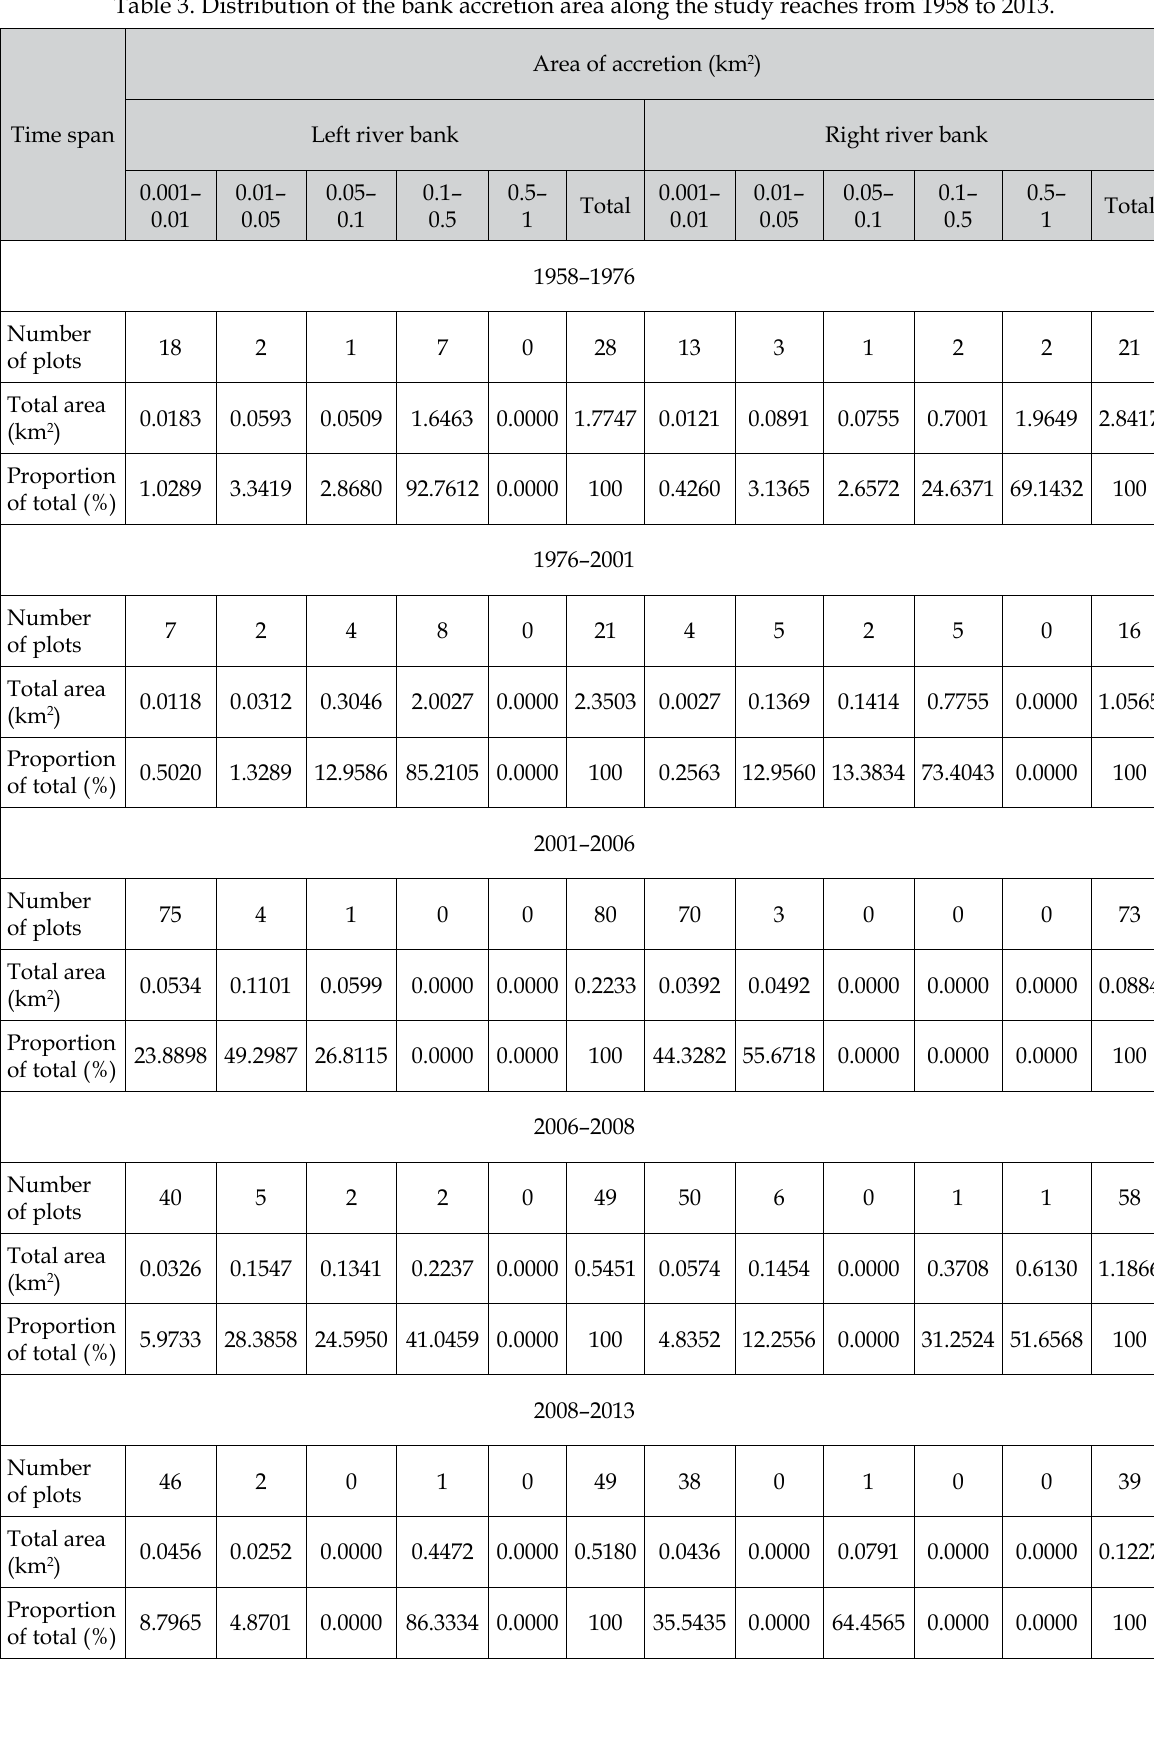
Table 3. Distribution of the bank accretion area along the study reaches from 1958 to